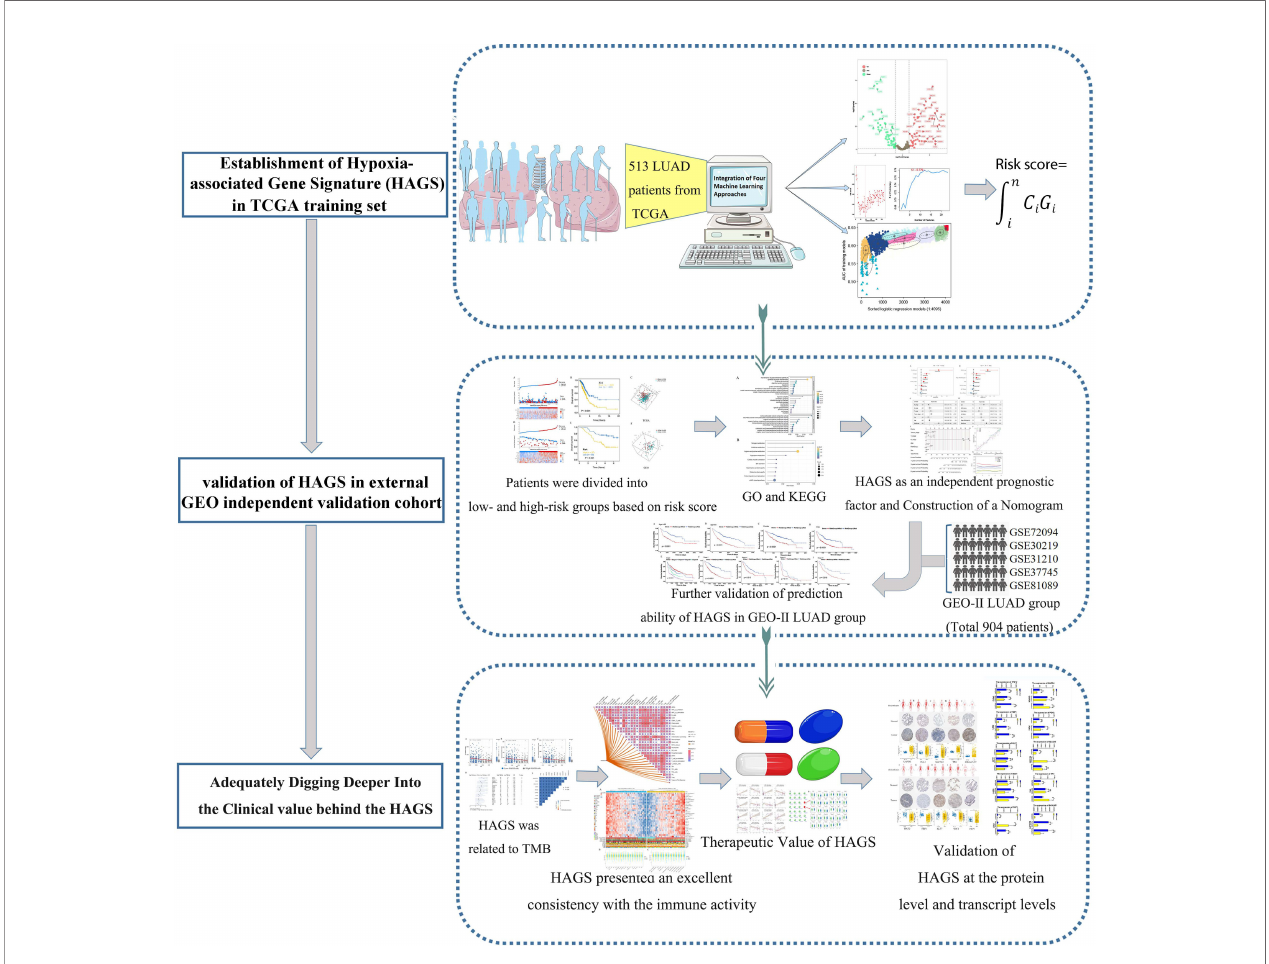
FIGURE 1 | Flowchart for developing an individualized hypoxia-associated gene-based prognostic signature for